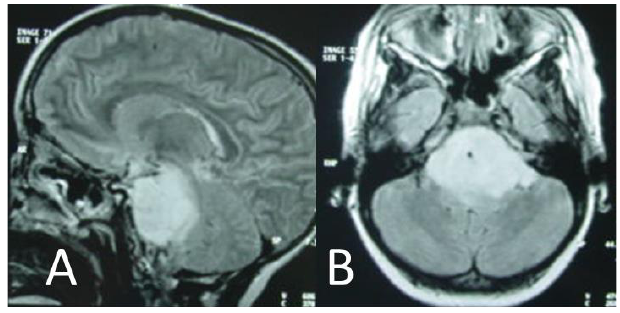
Figure 3 - Diffuse tumor (Type I) affecting the pons. (A) Sagittal Flair (B) Axial Flair Focal Brainstem Tumors (Type II)